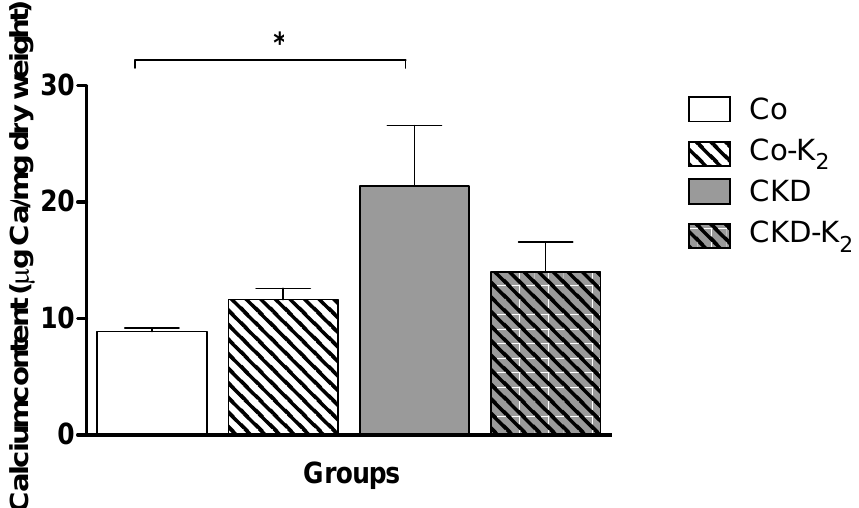
Figure 4. Myocardial calcium content. Measurement of myocardial calcium content using atomic absorption spectrometry in µ g Ca/mg dry weight tissue. CKD animals display a significantly increased myocardial calcium content compared to Co animals. Co = control group; Co-K 2 = MK-7 supplemented control group; CKD = 5/6 nephrectomized group; CKD-K 2 = MK-7 supplemented 5/6 nephrectomized group; mg = milligrams; µg = micrograms. Significant differences: * p < 0.05. Kidney : In renal tissues of CKD and CKD-K animals we detected tubular calcification easily 2 visible on von Kossa histology (Figures 5 and 6). Quantitative analysis detected no effect of MK-7 supplementation on renal calcification.